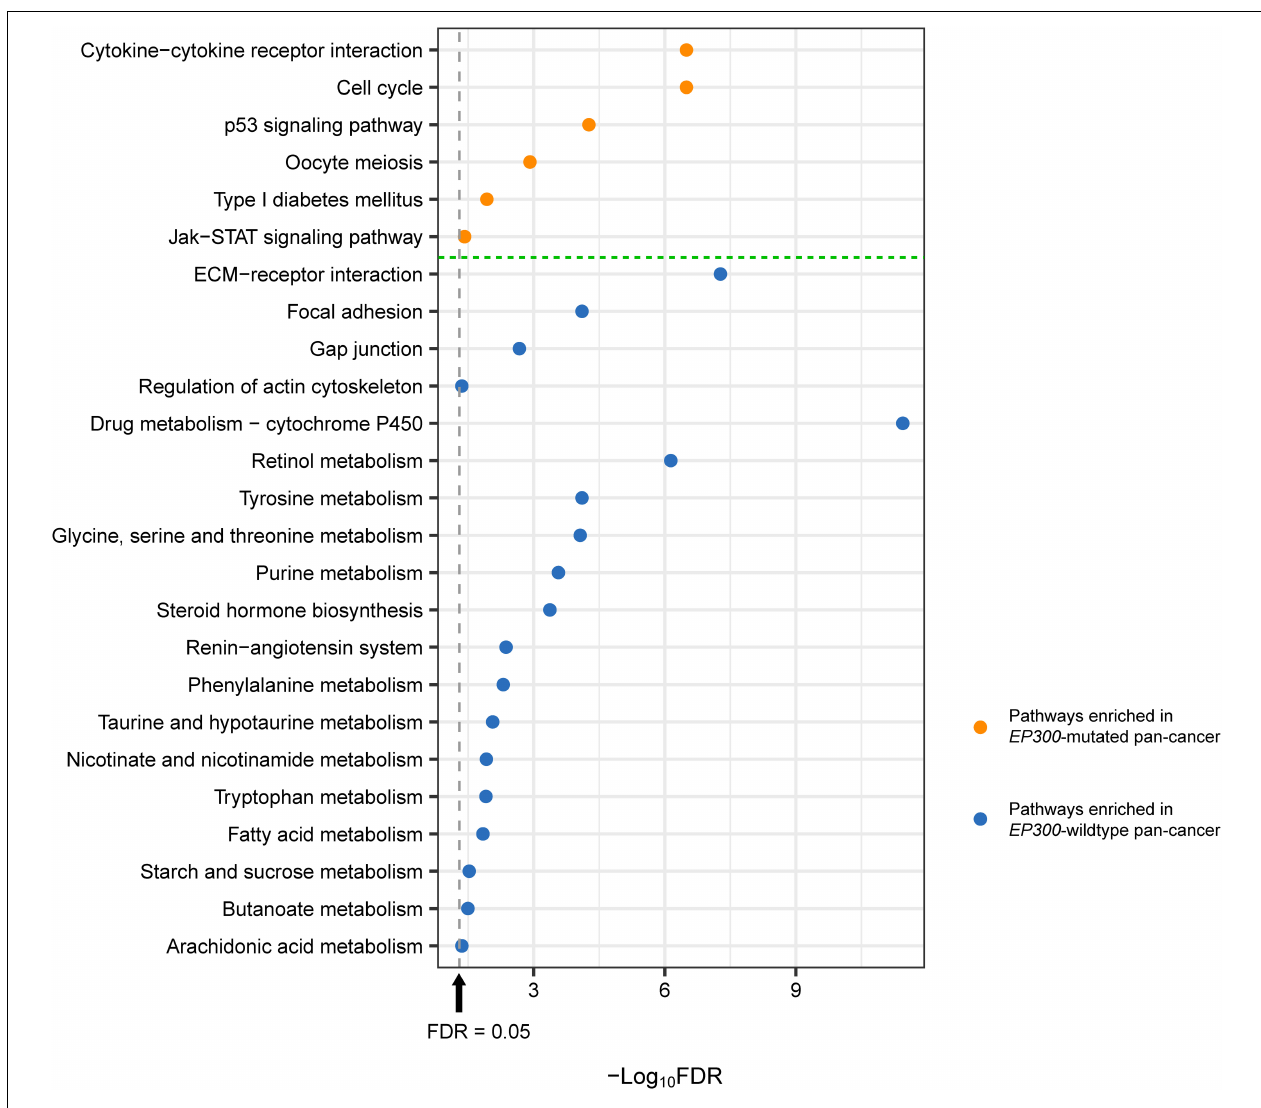
FIGURE 3 | Kyoto Encyclopedia of Genes and Genomes (KEGG) pathways highly enriched in E1A binding protein p300 ( EP300 )-mutated and EP300 -wild-type pan-cancer. These pathways were identified based on the differentially expressed genes between EP300 -mutated and EP300 -wild-type pan-cancer [Student’s t -test, false discovery rate (FDR) < 0.05, fold change (FC) > 1.5] by Gene Set Enrichment Analysis (GSEA) (Subramanian et al., 2005) with a threshold of FDR < 0.05. The FDR was the adjusted p -value evaluated by the Benjamini and Hochberg method (Benjamini and Hochberg,